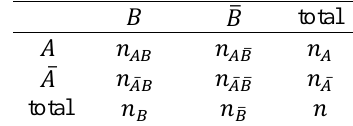
Table 1. Contingency table for rule 𝐴 →